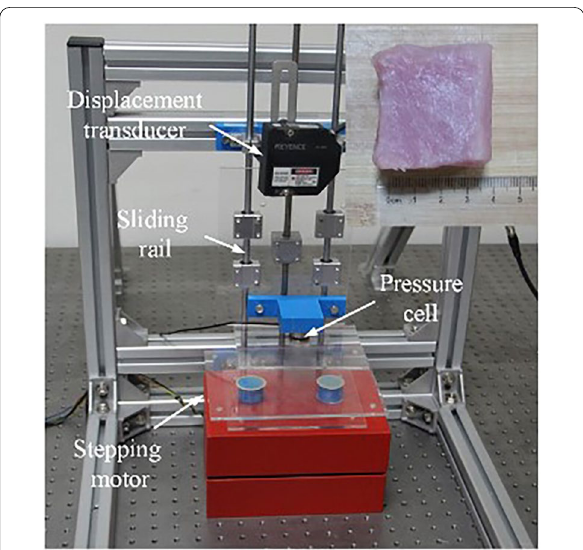
Figure 2 Compression device and